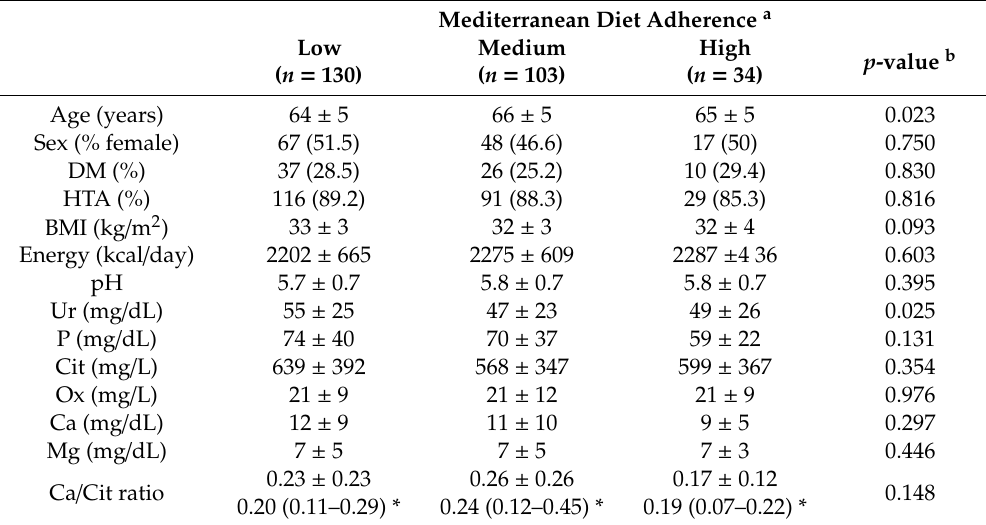
Table 2. Baseline characteristics and urinary parameters of groups that had low, medium, and high adherence to the MedDiet. Results are expressed as means ± SDs or n